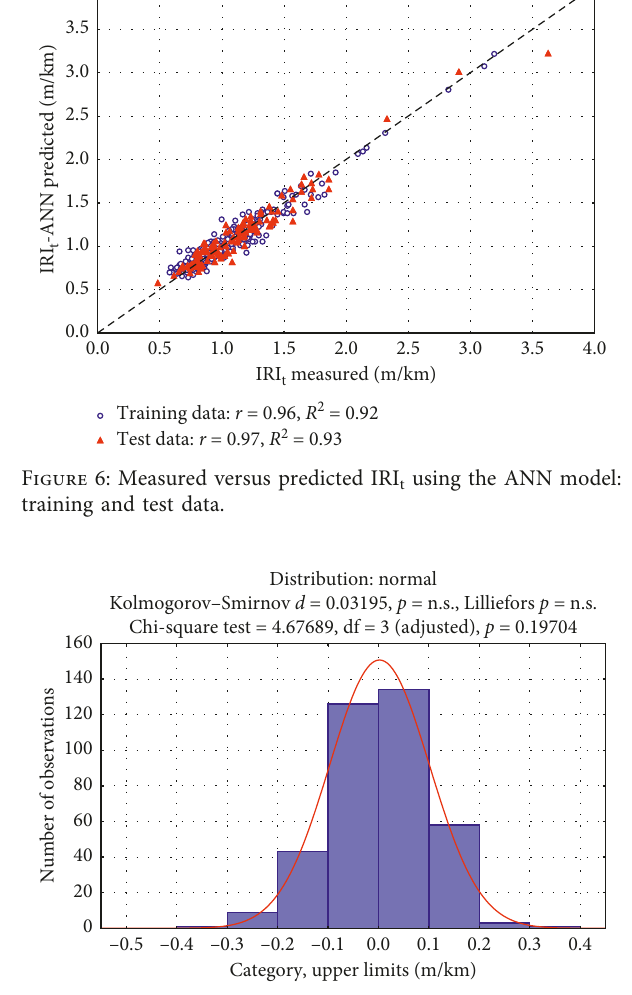
Figure 7: Distribution of prediction errors of the ANN